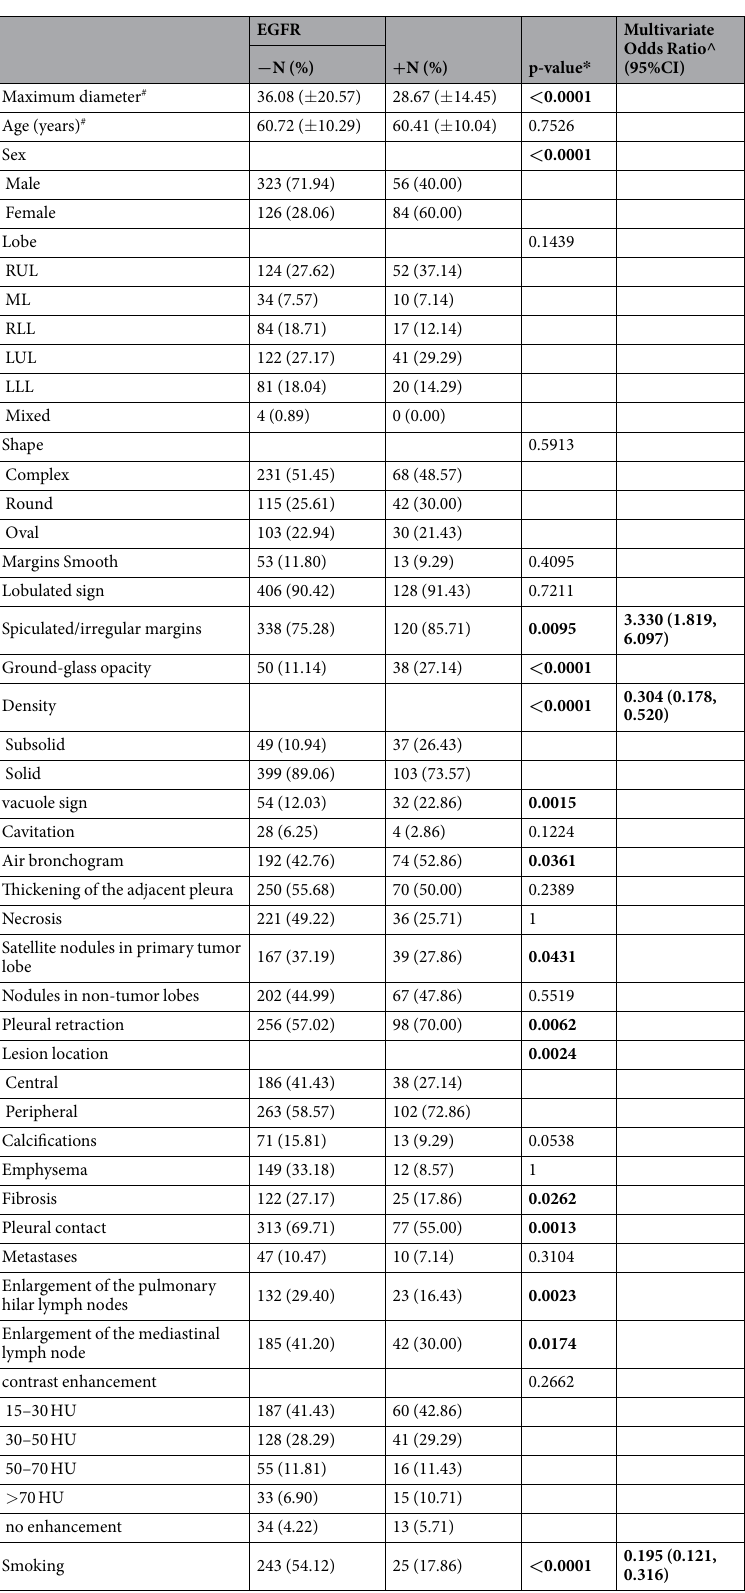
Table 3. Univariate and multivariate analyses of the EGFR wild type and EGFR mutation in exon 21. CI = Confidence interval. Note: significant ORs and p-values are in bold. # Mean ( ± SD). * Non-parametric two-sample Wilcoxon test for continuous variables. * Chi-square test and Fisher’s test for categorical variables. ^Obtained by logistic regression model with stepwise selection of variables. $ Per 10-mm